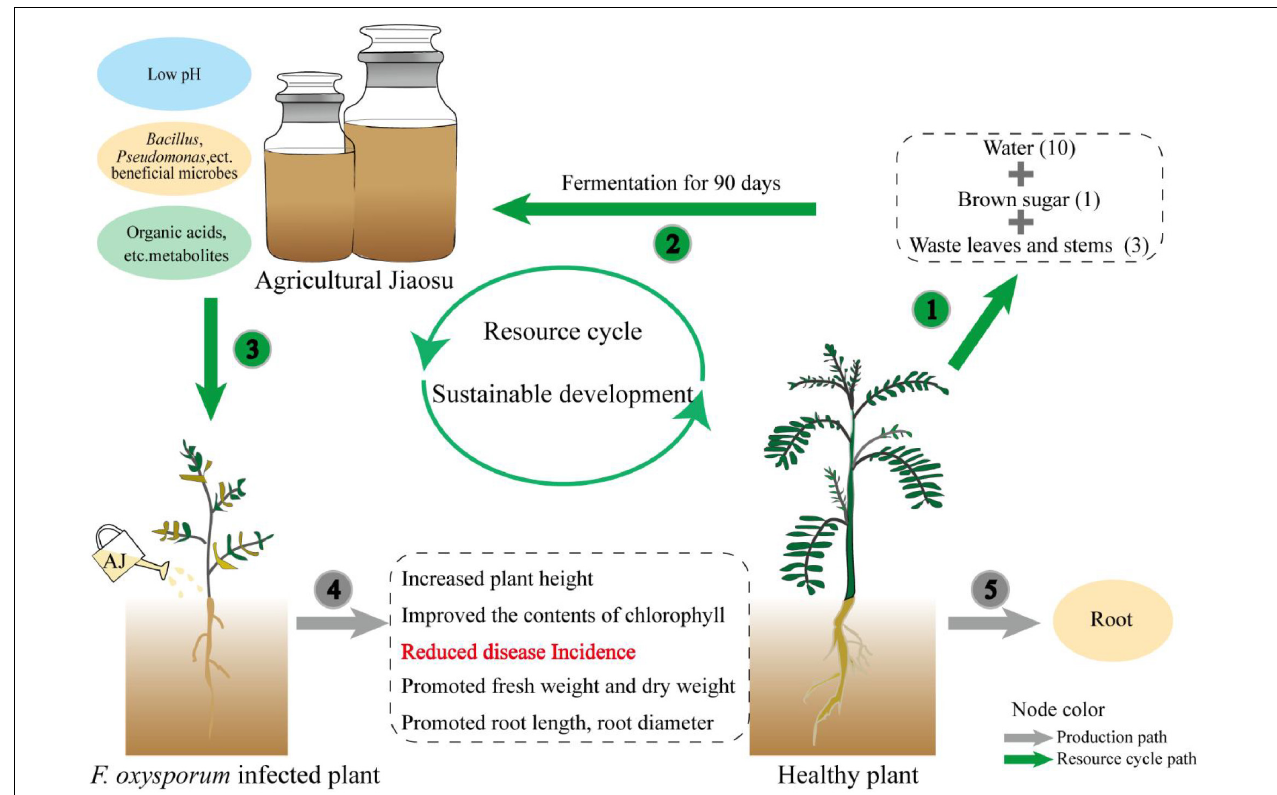
FIGURE 6 | Conceptual model illustrating how the application of AJ can establish a whole plant recycling pattern to promote the sustainable development of medicinal